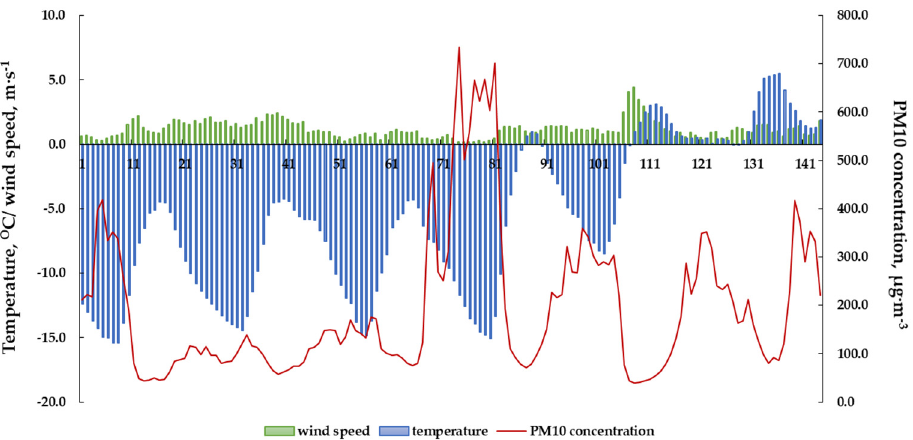
Figure 5. Changes in PM10 concentration depending on the ( a ) air temperature and ( b ) wind speed that occurred in the 2018 heating season in Rybnik .